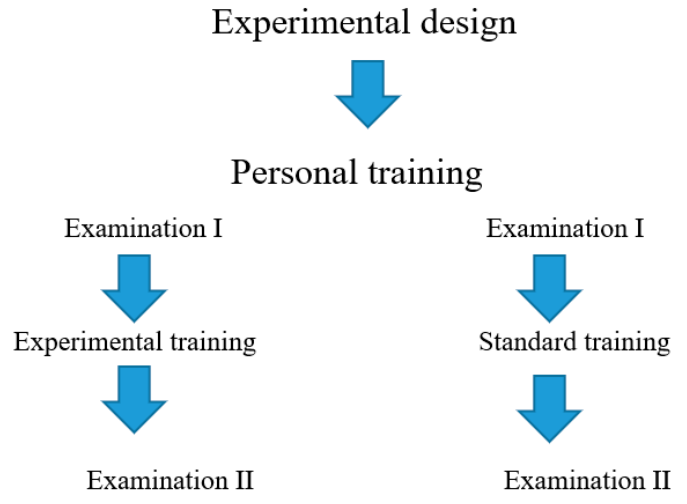
Figure 1. Training scheme. Source: own study